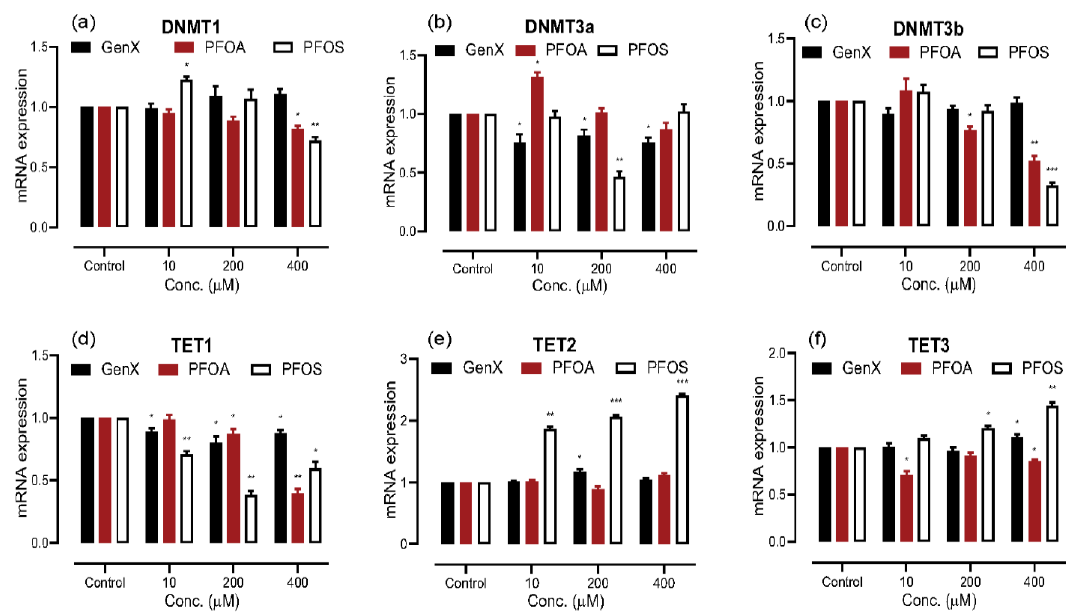
Figure 2. Epigenetic analysis of A549 cells exposed to GenX, PFOA and PFOS for 48 h, through quantitative real-time polymerase chain reaction (qRT-PCR). ( a ) and ( c ) DNA methyltransferases (DNMT)1 and DNMT3b mRNA expression significantly decreased upon exposure to higher concentration of PFOA and PFOS. ( b ) DNMT3b mRNA expression did not show any particular trend. ( d ) Dose-related statistically significant decrease in mRNA expression of Ten-eleven translocation (TET)1. ( e ) Dose-related statistically significant increase in mRNA expression of TET2 upon PFOS exposure. ( f ) An increase in mRNA expression of TET3 when exposed to higher doses of PFOA and PFOS. The data are given as the mean ± S.D. for three independent experiments (n = 3) (* = p < 0.05, ** = p < 0.005, *** = p < 0.001).